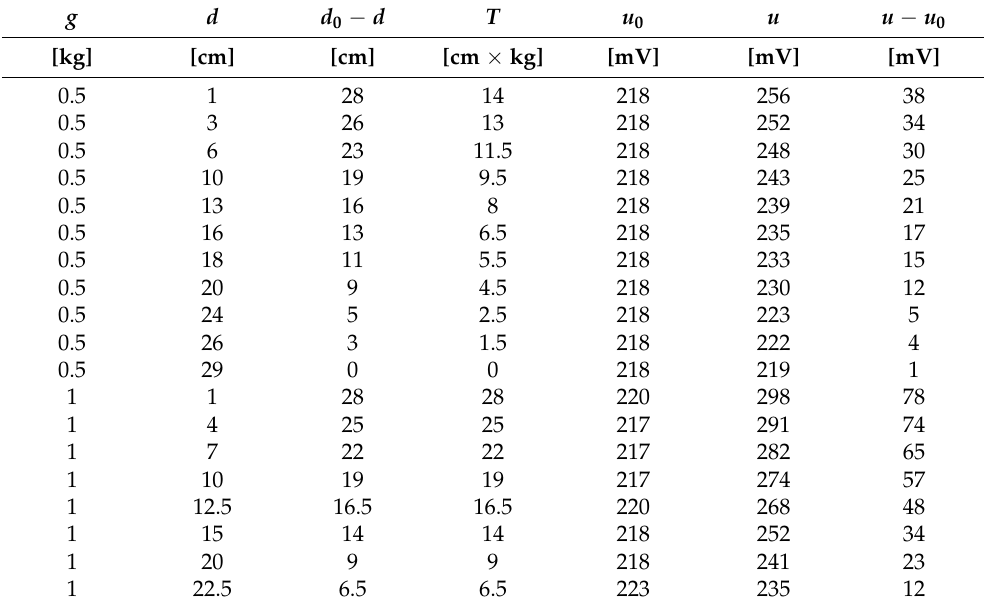
Table A1. Measurements used for